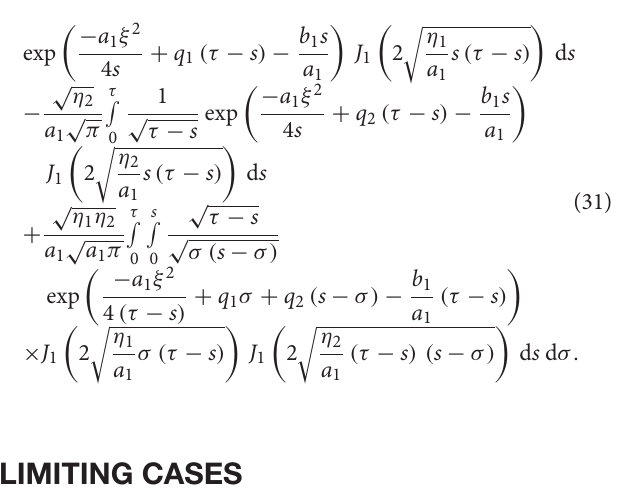
FIGURE 3 | Shear stress plots showing variations in K .